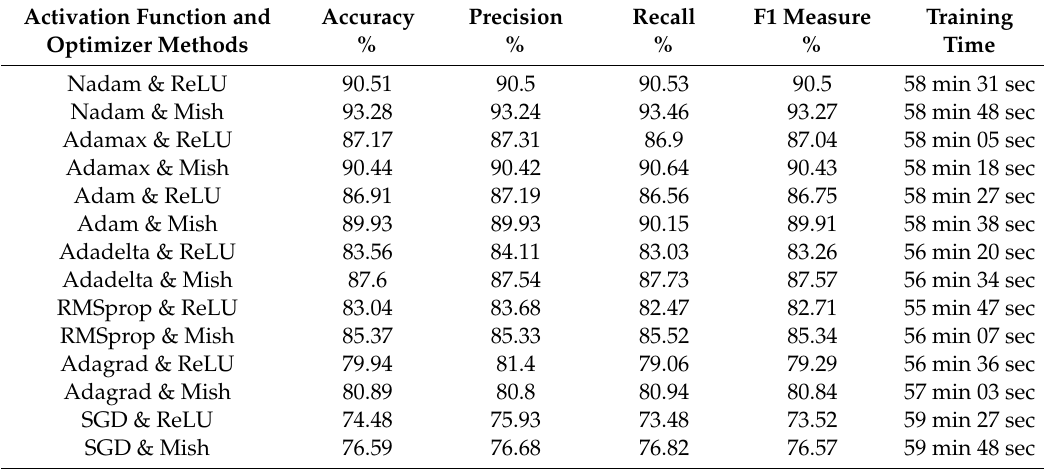
The comparative performance of MobileNet with Mish and ReLU using di ff erent optimizer